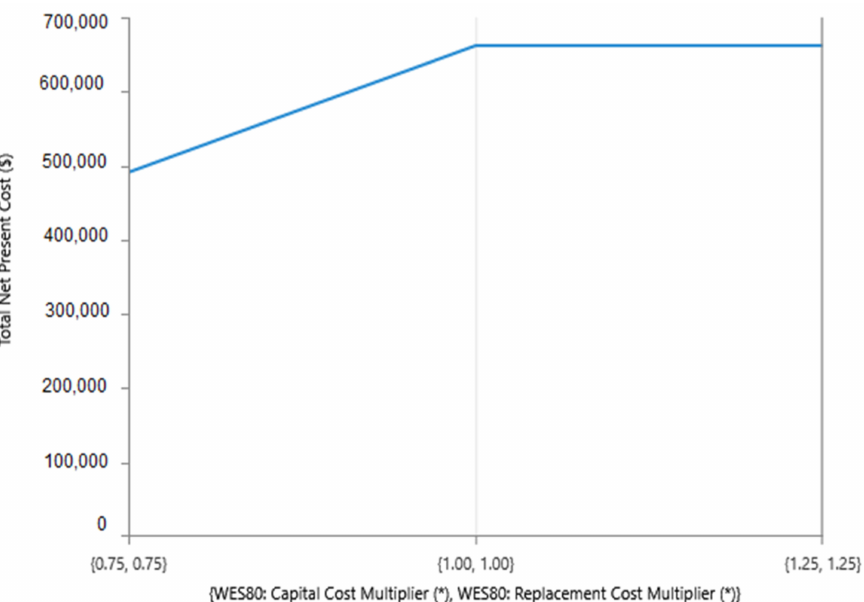
Figure 16. Effect of Wind Turbine Cost on TNPC of the proposed